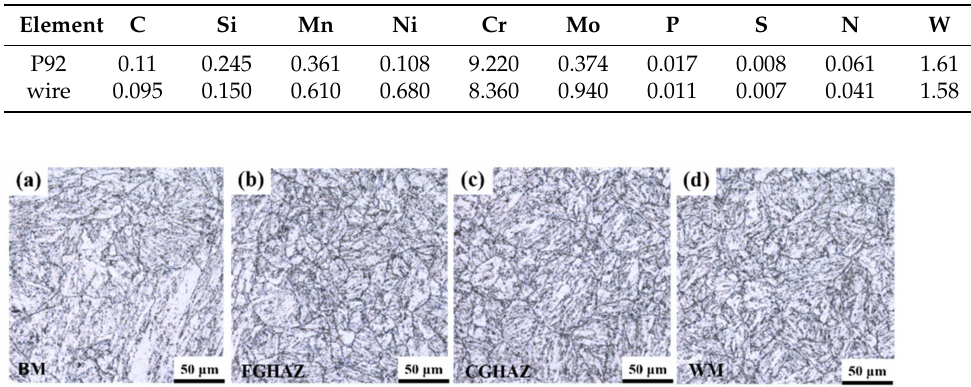
Figure 1. ( a ) Optical macrograph of the welded joint and ( b ) the illustration of the position and geometry of CF specimens from the P92 steel welded joint [22]. Table 1. Chemical compositions of Chinese P92 steel and welded joint (wt.%).